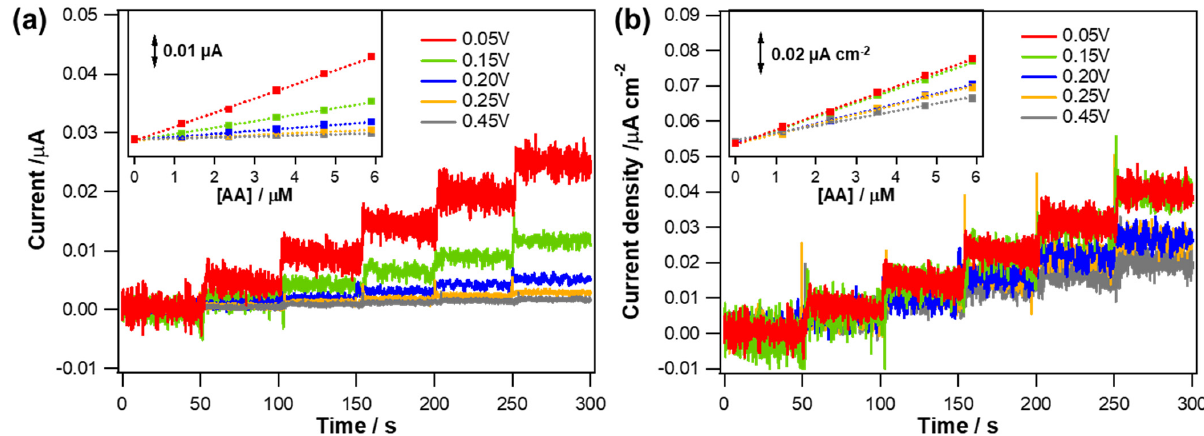
Figure 5. ( a ) Typical dynamic current response curves of the various Au electrodes electrodeposited at different deposition potentials (0.05 V to 0.45 V) to AA concentration changes in deaerated PBS solution (pH 7.4) measured at an applied potential of − 0.05 V (vs. Ag/AgCl). ( b ) The current data in ( a ) were normalized to the corresponding electrode ESAs. Insets show the corresponding calibration curves.